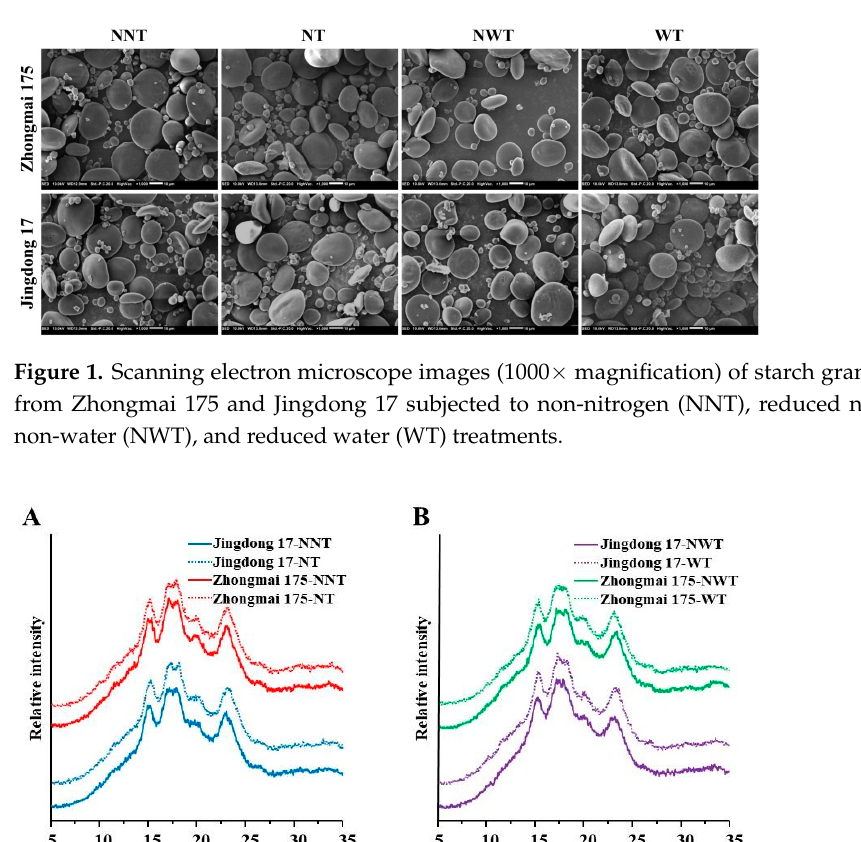
Figure 1. Scanning electron microscope images (1000× magnification) of starch granules isolated from Zhongmai 175 and Jingdong 17 subjected to non-nitrogen (NNT), reduced nitrogen (NT), non-water (NWT), and reduced water (WT) treat- ments.